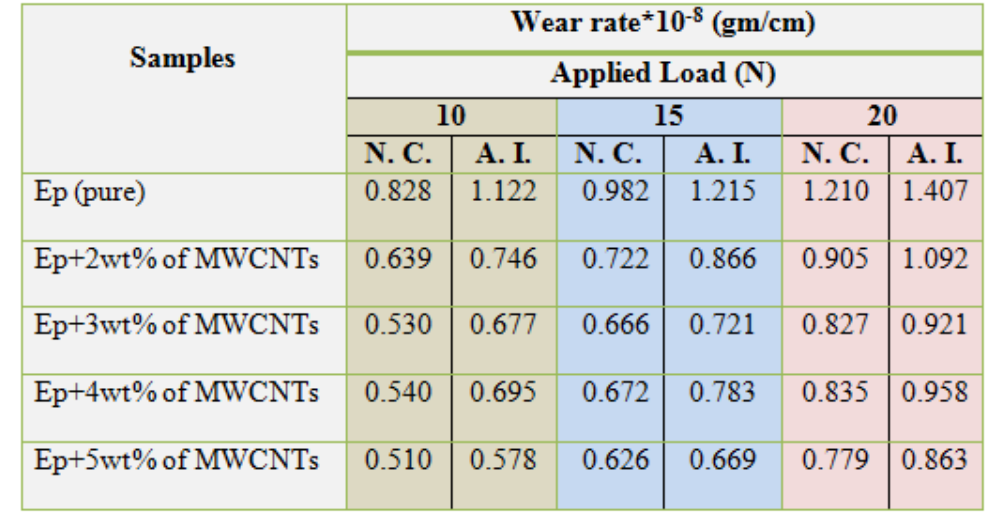
Table 3: Variation of the wear rate values with applied load for Ep/MWCNTs nanocomposites at natural condition and after